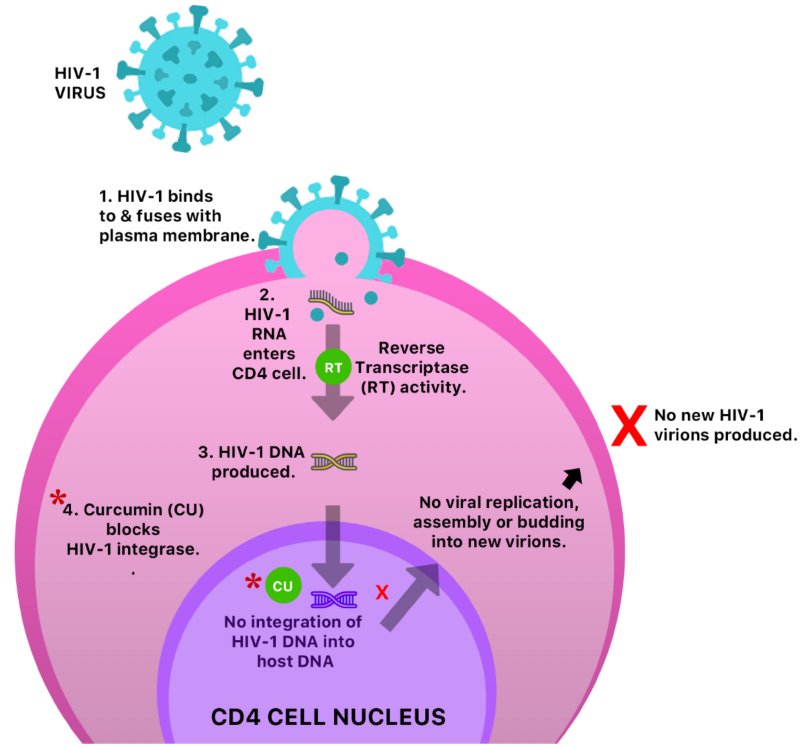
Figure 11. A possible anti-HIV-1 mechanism of curcumin by inhibition of HIV-1 integrase. This pre- vents integration of HIV-1 DNA into host cell DNA and ultimately inhibition of viral replication, assembly, budding and infection of new